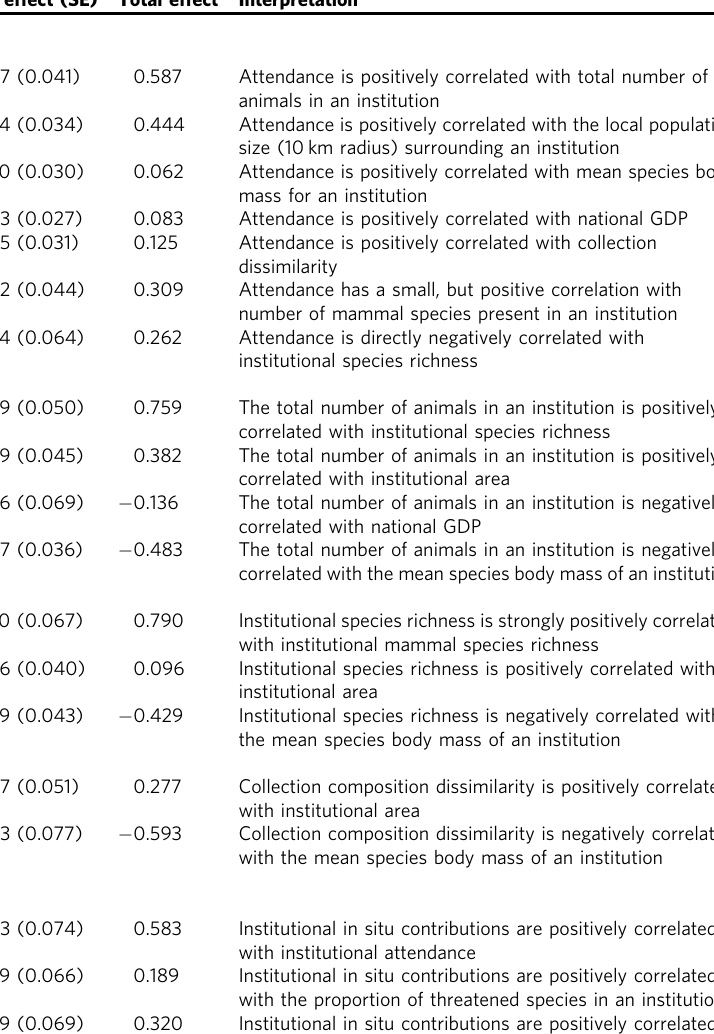
Table 2 Direct and total standardised effect sizes and proposed interpretations for both the attendance and in situ